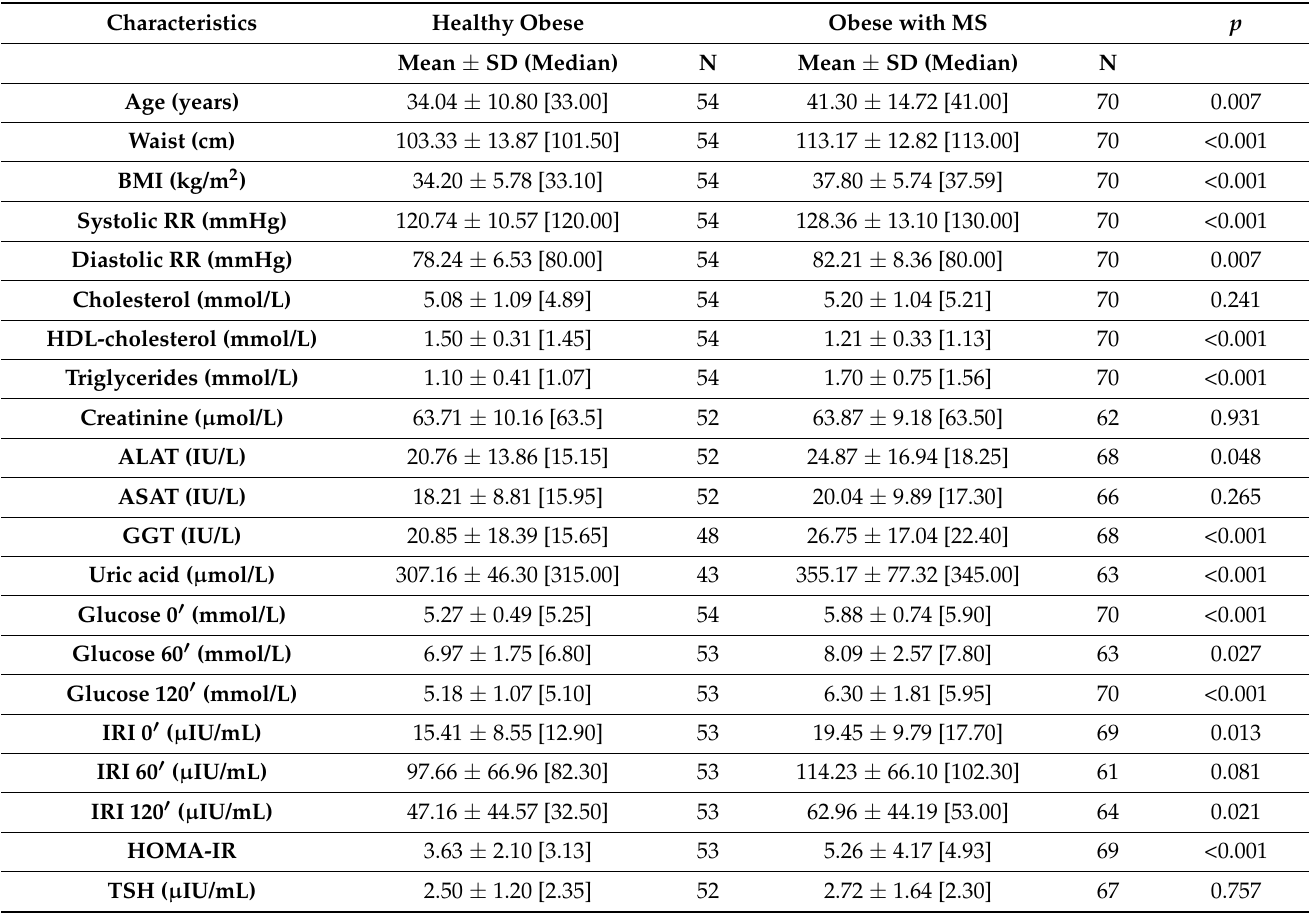
Table 2. Characteristics of overweight and obese non diabetic female patients without metabolic syndrome (MC) (Healthy obese) compared to overweight and obese non diabetic women with MS (Obese with